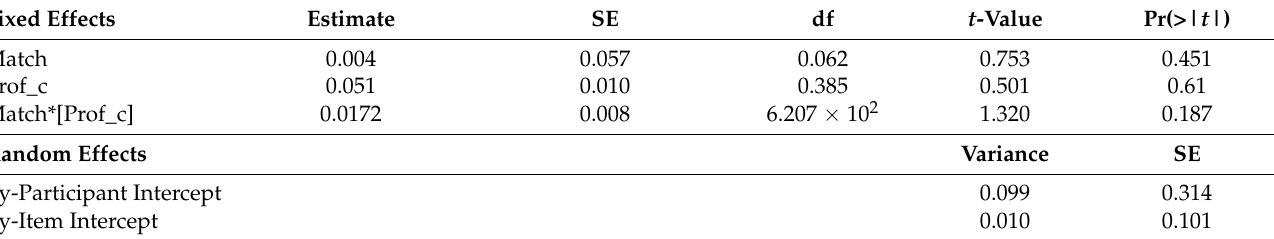
Table A4. Linear mixed-effects model, Region 7, Proficiency and Match, L2